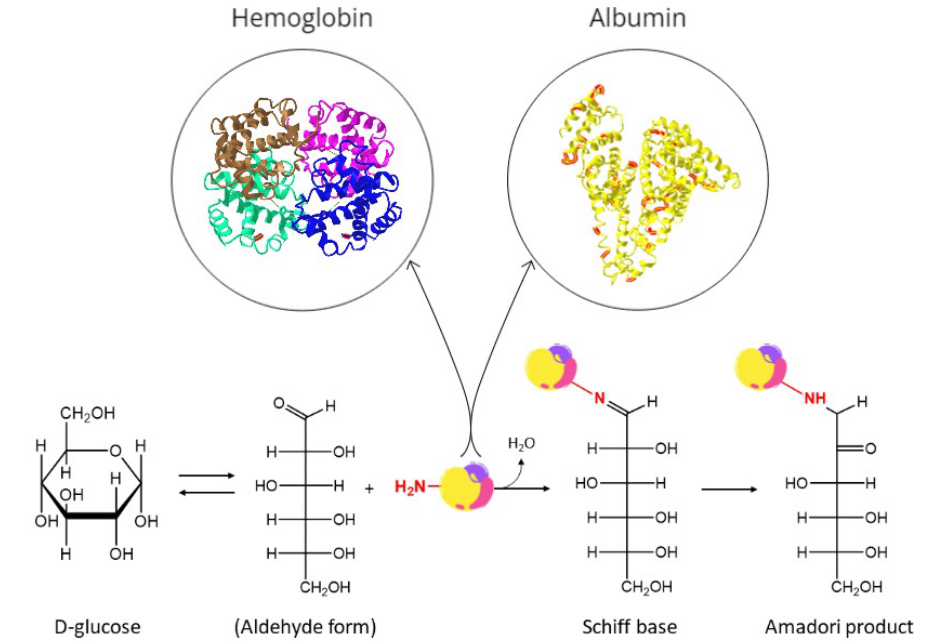
Figure 1. Reactions involved in the glycation of proteins. In particular, hemoglobin (PDB ID: 1BBB) and albumin (PDB ID: 1AO6) have been reported, and the main glycation sites for each of them have been highlighted in red: N-terminal valine of the β -chains of hemoglobin, and lysine and arginine residues of